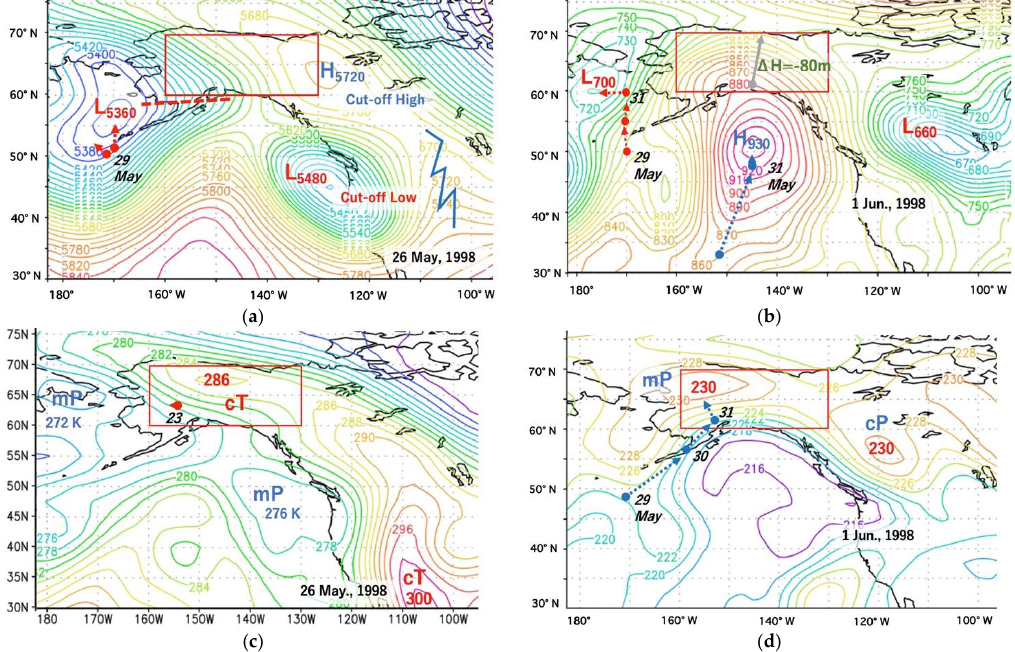
Figure 9. Fire weather during the 1998 Carla Lake Fire in Alaska. Blue dotted lines with a solid circle and an arrow at both ends indicate their positions and directions of movement of high-pressure systems and cT. Red dotted lines with a solid circle and an arrow at both ends indicate their posi- tions and directions of movement of low-pressure systems and mP. ( a ) Weather map (500 hPa) on 26 May. COH (cut-off high) at high latitude. The red dotted line show a major trough. The blue zigzag dotted line showa the major ridge. ( b ) Weather map (925 hPa) on 1 June, strong wind day. The grey line with a solid circle and an arrow at both ends shows the height gradient (ΔH = −8 0 m). ( c ) Temperature map (925 hPa) on 26 May. cT in Alaska. ( d ) Temperature map (200 hPa) on 1 June. mP and cP at high latitude.